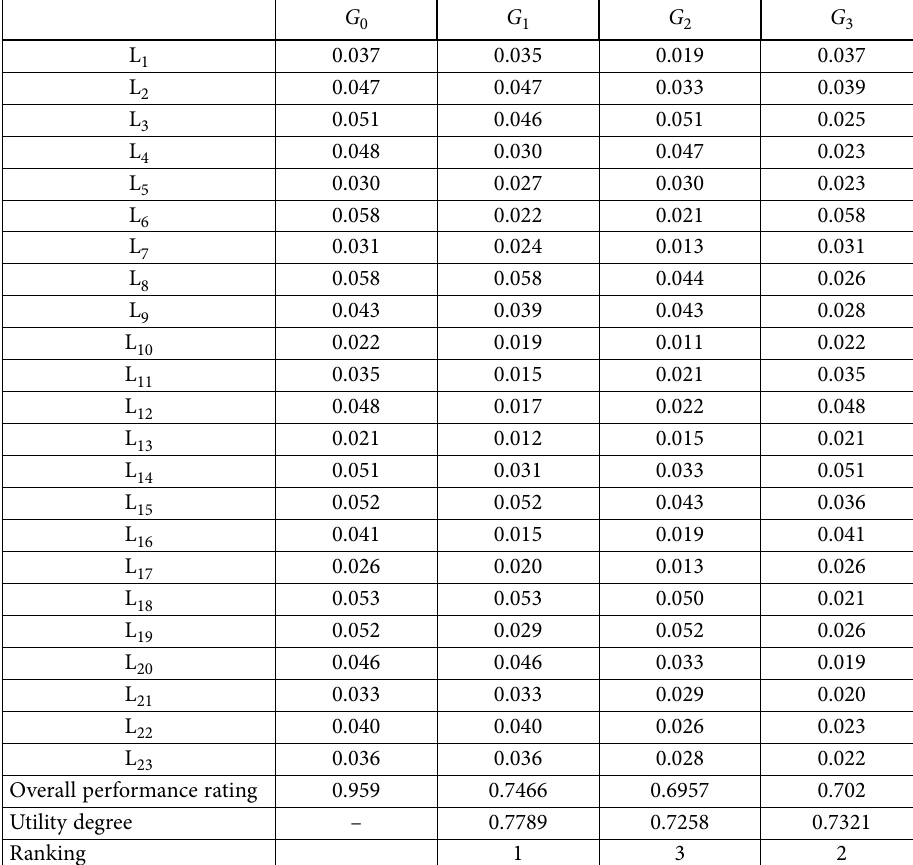
Table 10. Overall performance degree of organization of weighted evaluation